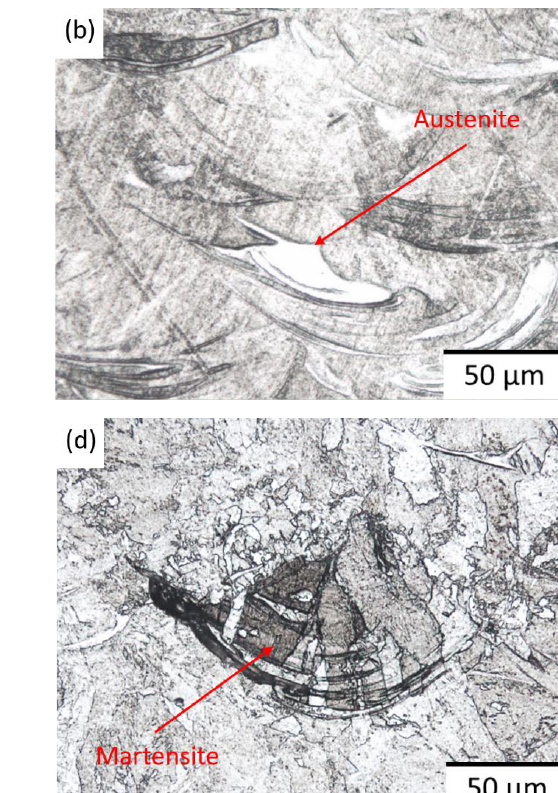
Figure 10. Columnar lath generation acress multiple meltpools.